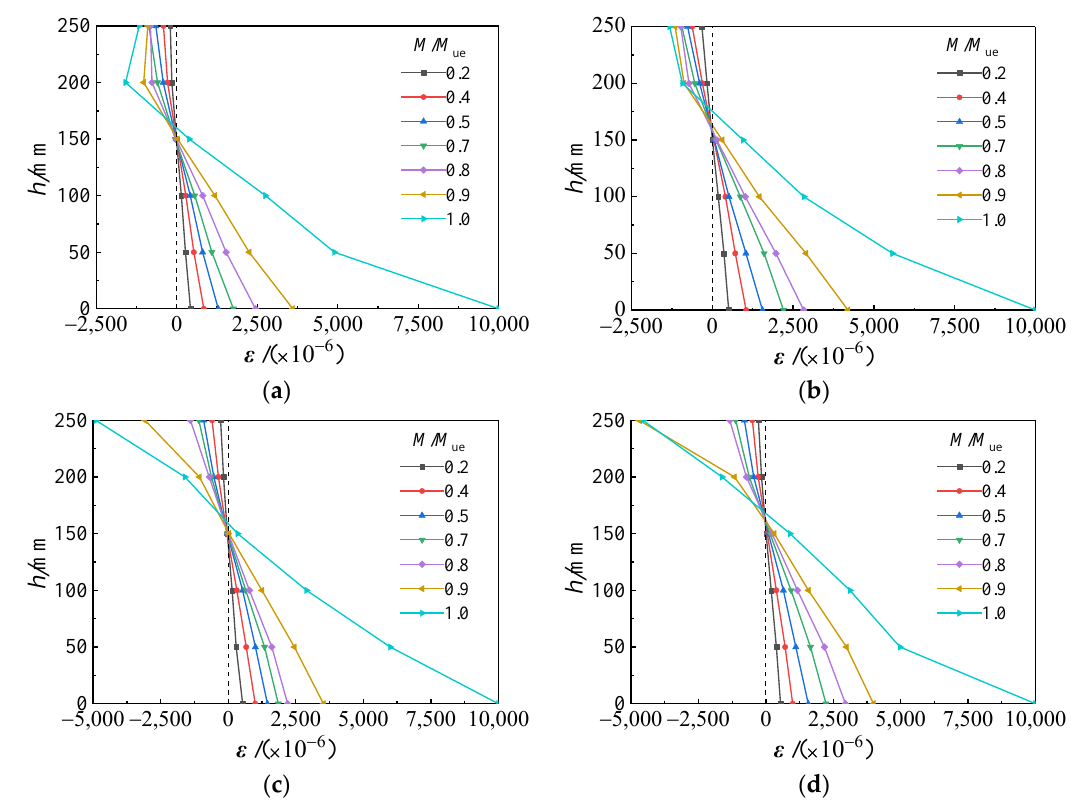
Figure 13. Longitudinal strain distribution along the height at the mid-span of specimens: ( a ) S-1; ( b ) S-2; ( c ) S-4; ( d ) S-5.